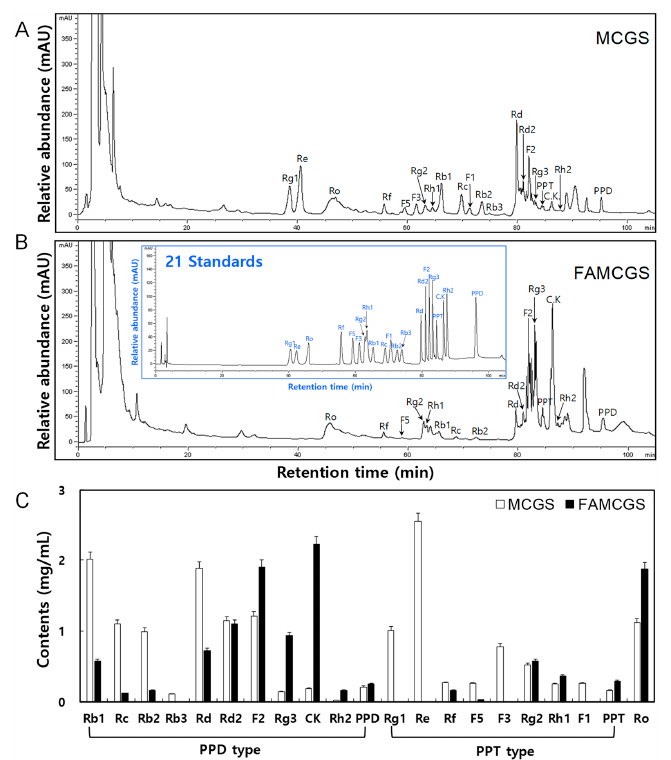
Figure 2. Typical HPLC chromatograms of ginsenosides in MCGSs and FAMCGSs. ( A , B ) Relative abundance of ginsenoside derivatives in 50% EtOH extract concentrates of MCGS ( A ) and FAMCGS ( B ). The HPLC chromatogram of the 21 standards are shown inside Figure 1B. ( C ) Comparison of ginsenoside contents in MCGSs and FAMCGSs. All values are presented as the mean ± SD of pentaplicate determinations. PPD and PPT represent protopanaxdiol and protopanaxtriol, respectively. MCGS, mountain-cultivated ginseng sprout; FAMCG, fermented and aged mountain-cultivated ginseng sprout.